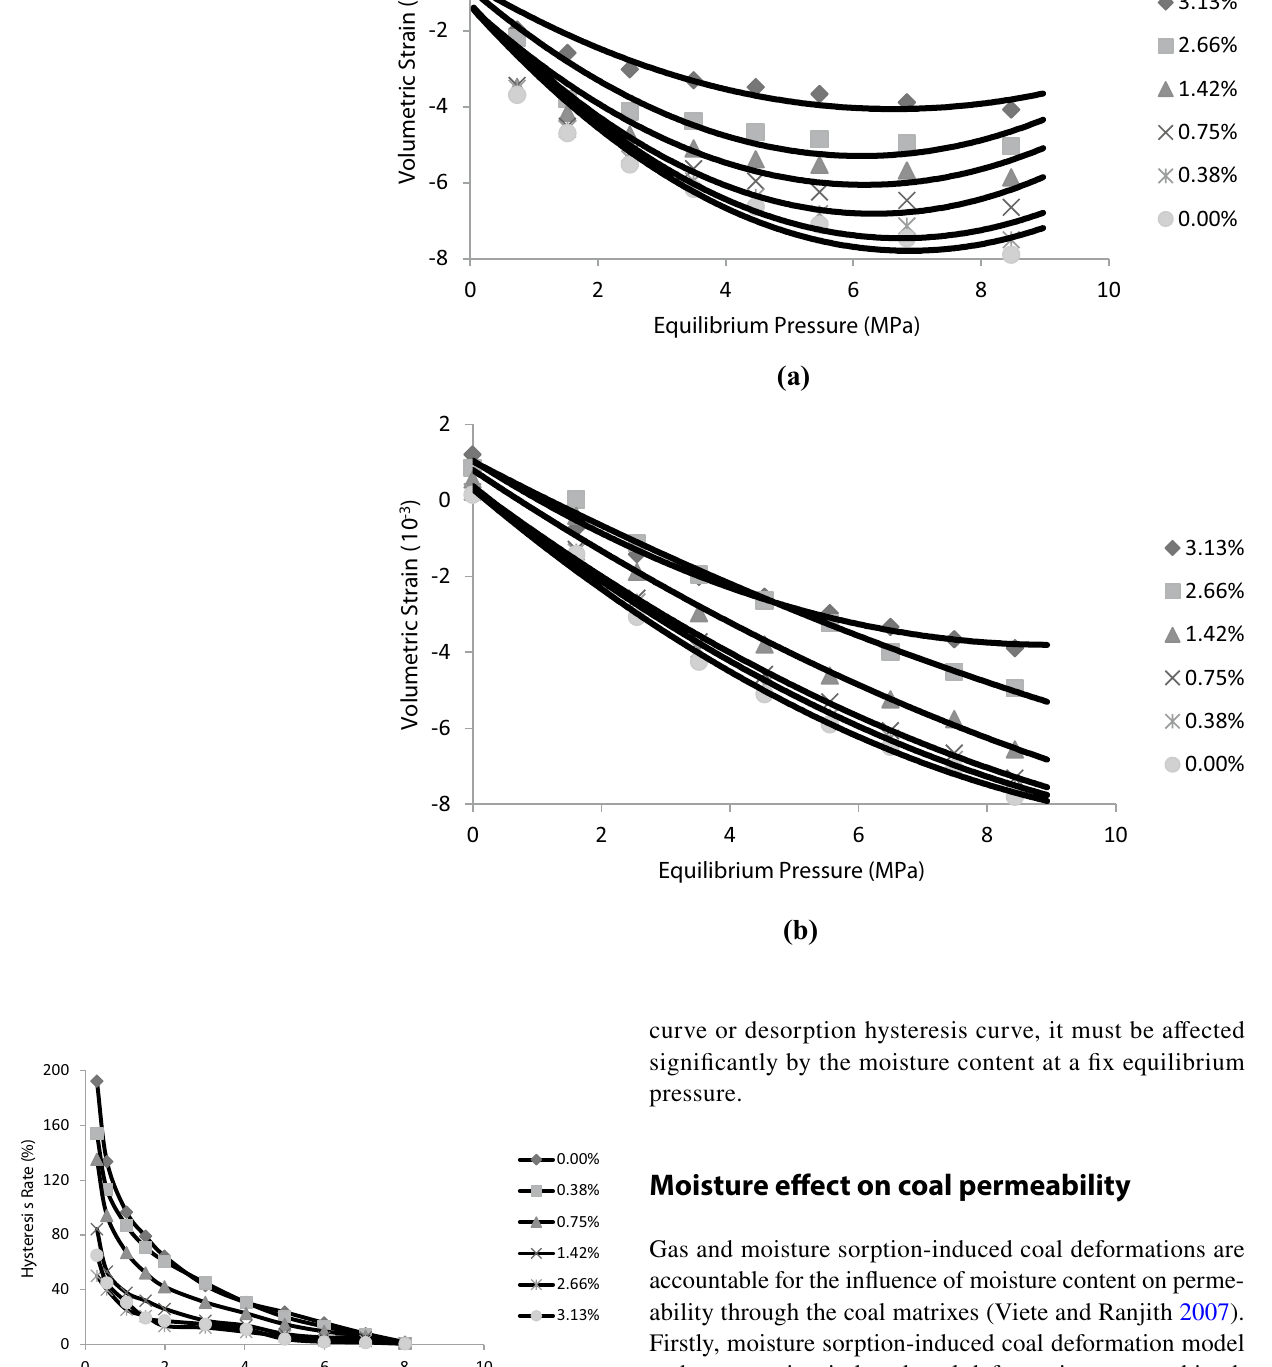
Fig. 4 The results of model validation. The line plots represent the model results: a swelling and b shrinkage